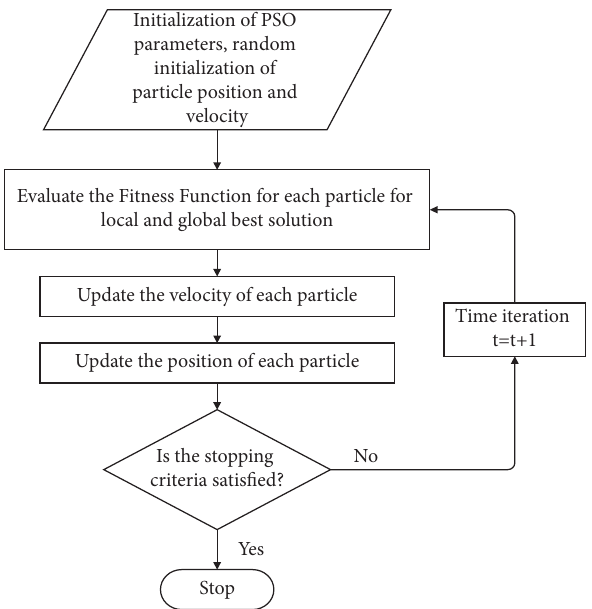
Figure 3: PSO algorithm flow